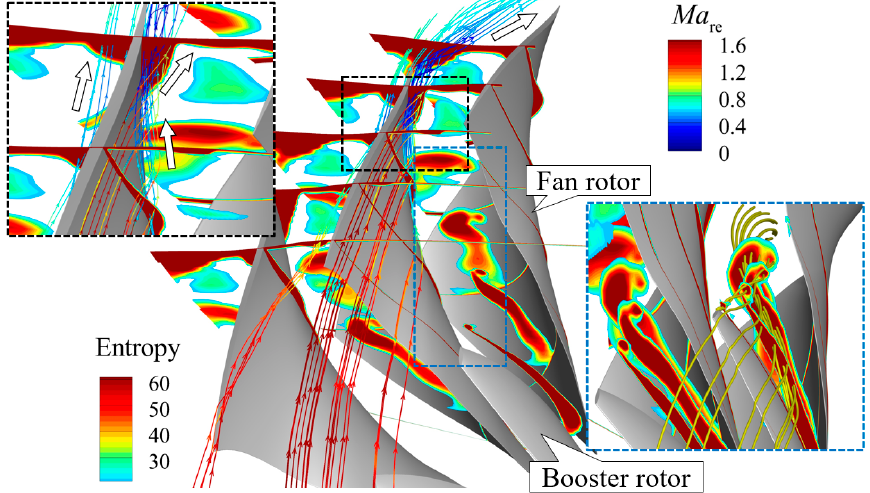
Figure 13. Streamwise entropy contour and 3D streamlines of the tandem rotor at N5.